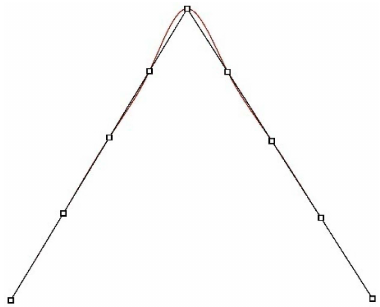
Figure 3. Third-degree base polynomials N 3 )( the interval [ t i , t i + 1 ) , there are four base polynomials involved in determining a single segment of the B-spline.